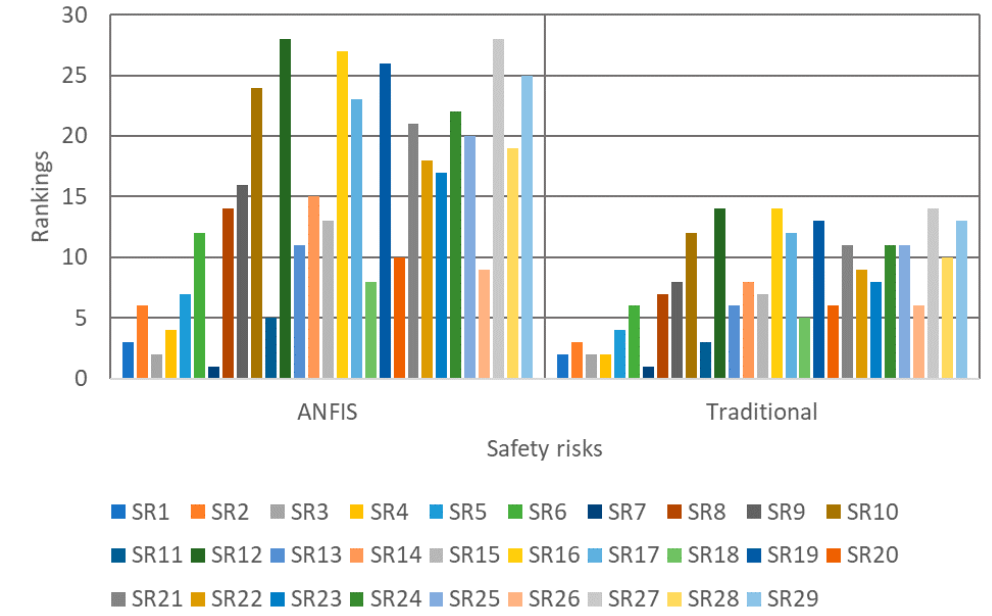
Figure 12. Results of comparative analysis.